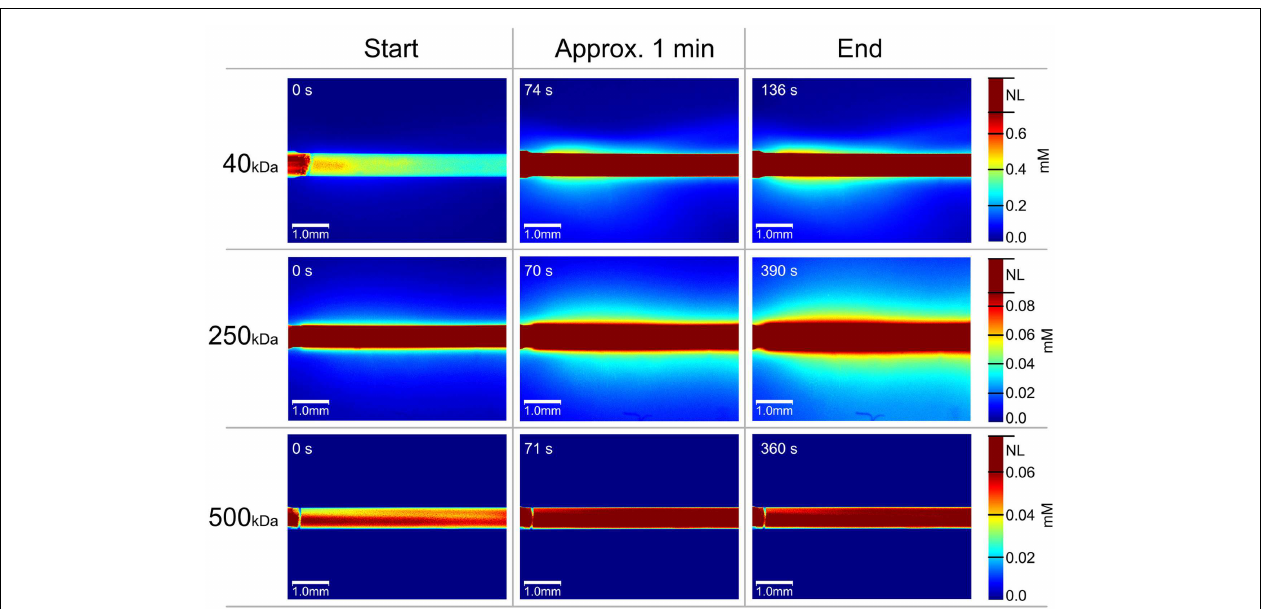
displayed in dark red. Hundred kilodaltons of MWCO membranes are used (100kDa Brain Microdialysis Catheter, M Dialysis AB). For Dextran 40 (kDa), three image timings are: 0s, 1min 14s, 2min 18s; for Dextran 250 (kDa), the image timings are: 0s, 1min 10s, 6min 30s; and for Dextran 500 (kDa), the image timings are: 0s, 1min 11s, 6min. Reprinted with permission from Chu (46). Copyright 2014 Springer Science